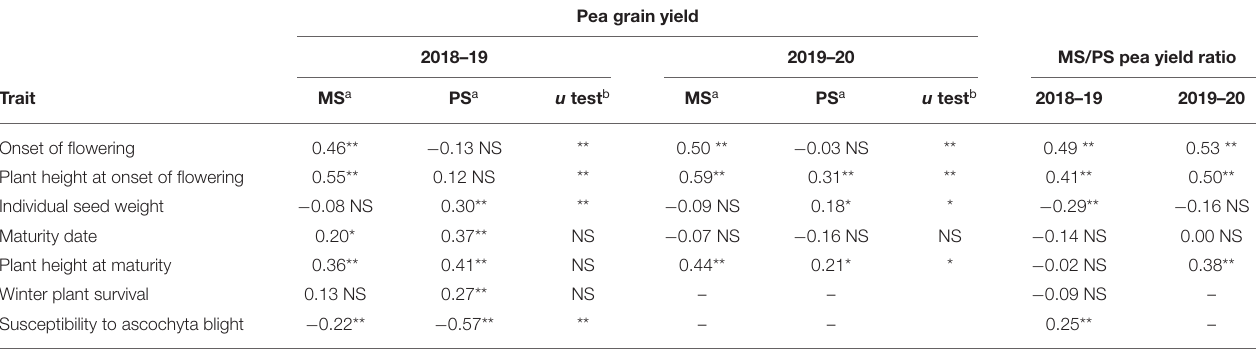
TABLE 4 | Phenotypic correlation of pea grain yield in mixed stand with cereals (MS) or in pure stand (PS) and ratio between MS and PS for pea grain yield with pea morphophysiological traits in PS, for 144 pea inbred lines grown in two cropping years.